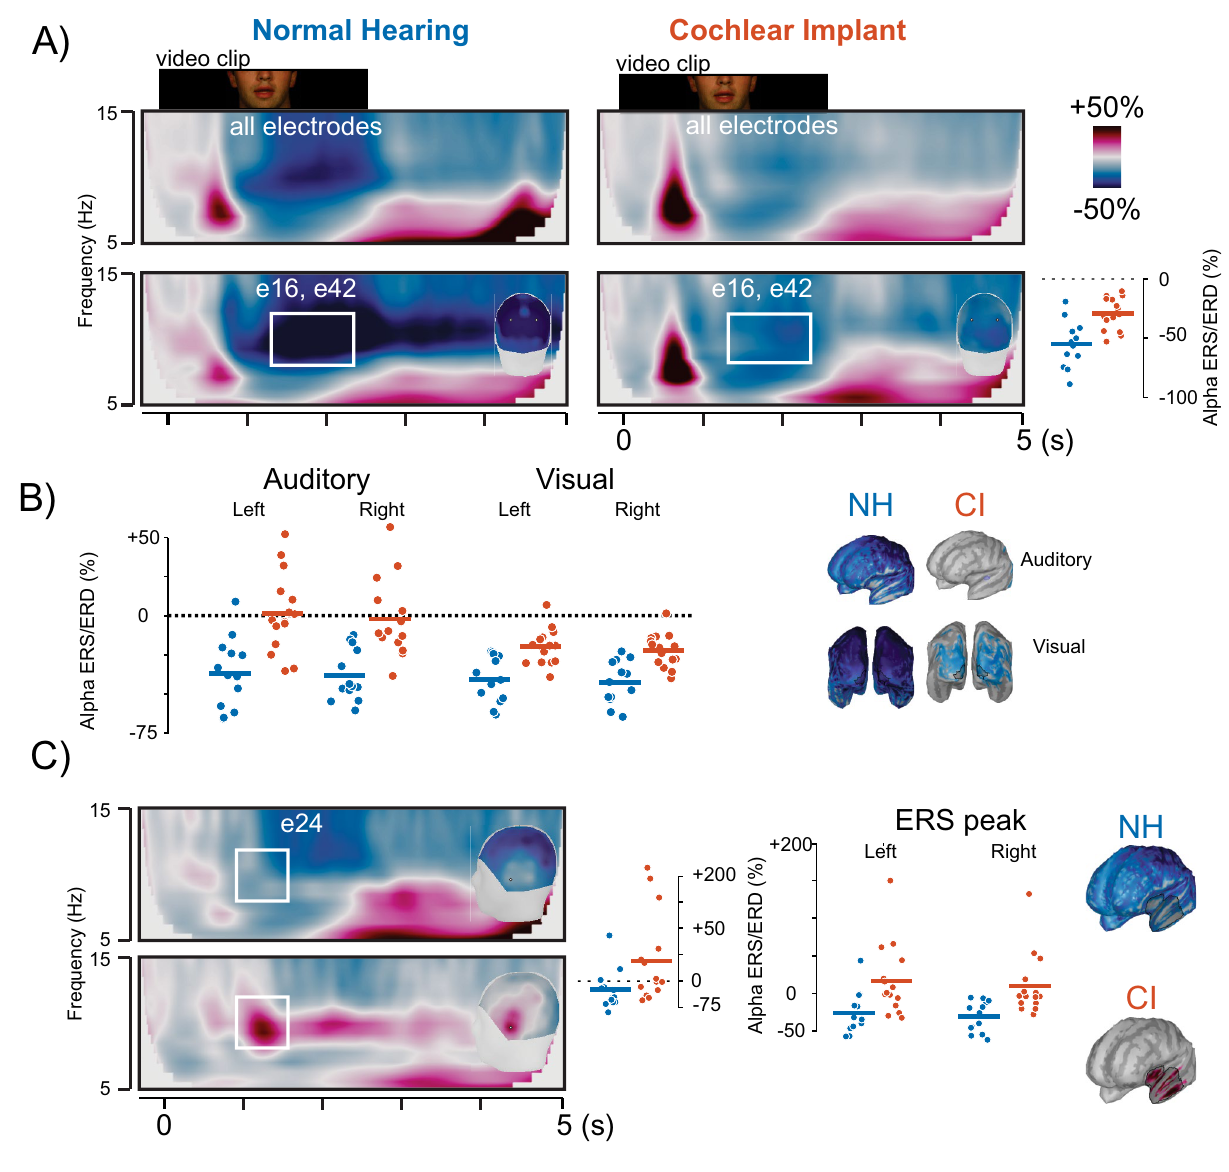
Figure 3. Neural oscillation analysis. ( A ) EEG event-related synchronization and desynchronization (ERS/D) across frequencies expressed as a percent change of power from baseline for all electrodes (top row) and occipital sensors e16 and e42 roughly approximating channels O1 and O2 as seen on 3D head shapes within time frequency plots (bottom row). The Scatterplot in the rightmost panel compares ERS/D for CI (red) and NH (blue) groups in the time frequency range outlined in the bottom row (white box) for 8 to 12 Hz alpha power from ~ 1.3 to 2.3 s where the ERD was at maximum. ( B ) Activity in auditory and visual ROIs in left and right hemispheres for the source of the ERD is shown for individual subjects in CI (red) and NH (blue) groups. Whole-brain plots show distributions of alpha power ERS/ERD from left frontal (top) and posterior (bottom) views. ( C ) CI users produced an alpha ERS in grand average plots across sensor e24 (approximating FT7). Individual differences in ERS/D for both groups are plotted in as scatters in the middle panel for sensor e24, as well as bilateral regions of superior temporal cortex where sources of alpha ERS were found in CI users (rightmost panel). For all scatterplots, colored horizontal lines reflect group